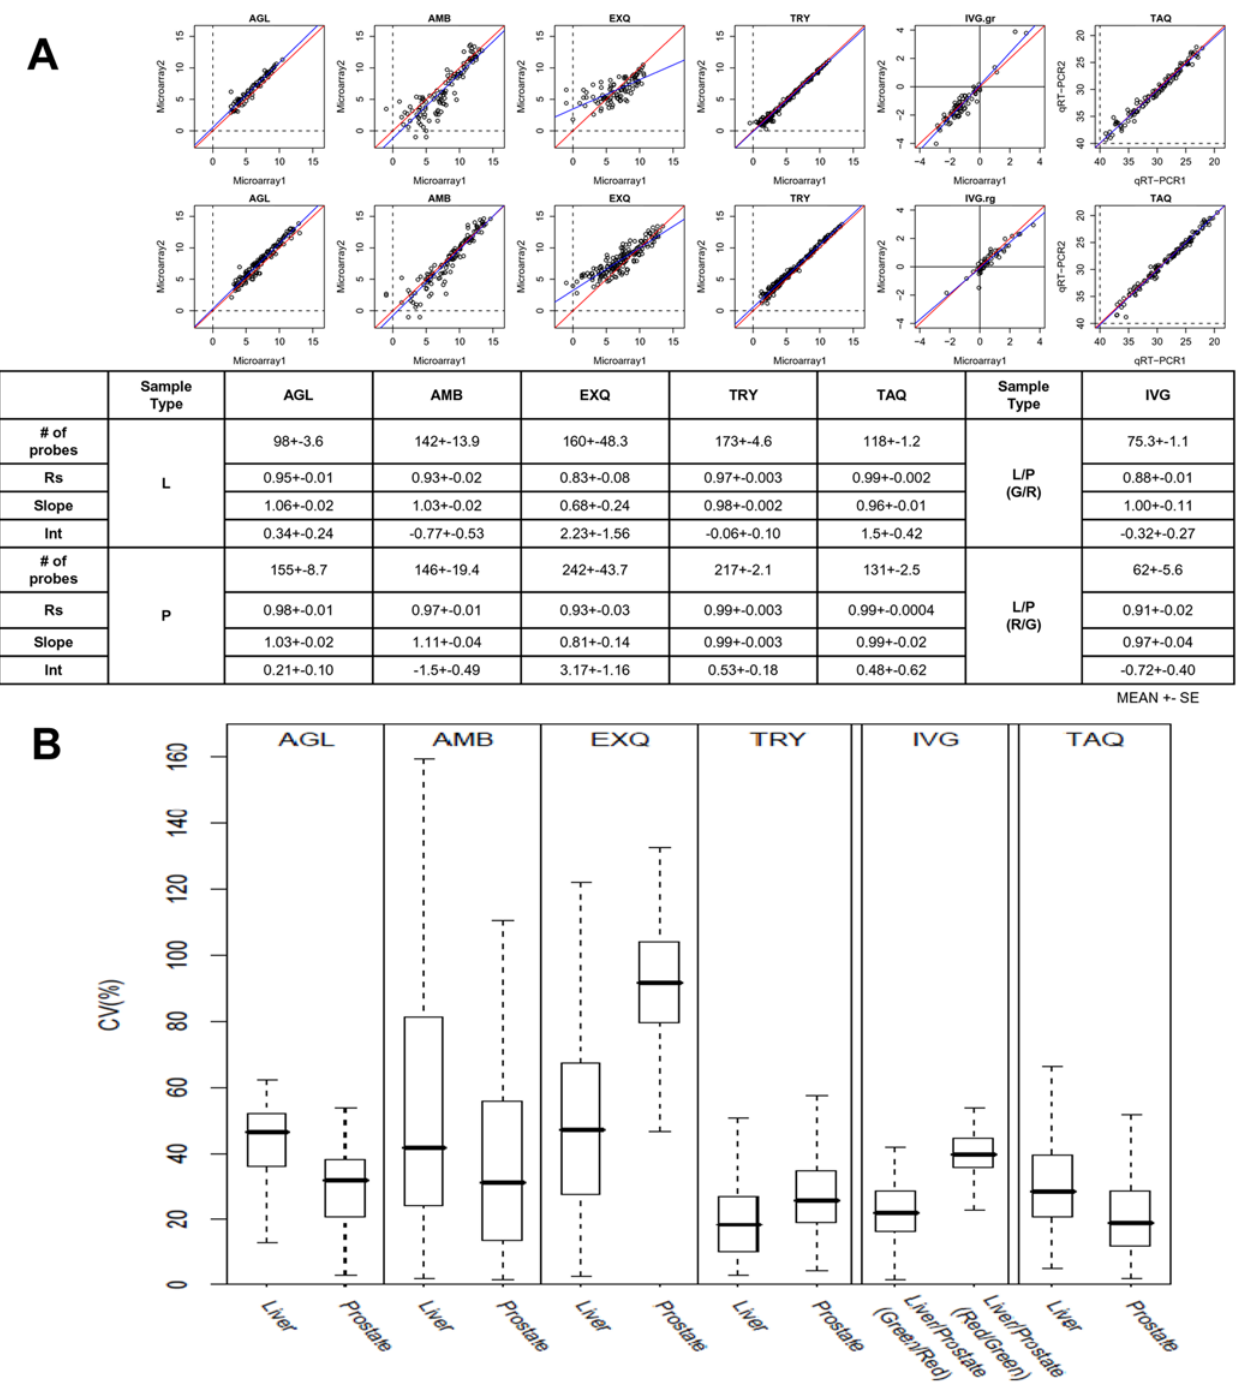
Figure 2. Intra-platform repeatability of quantitative assessment of microRNA expression. MicroRNA measurement of the same sample (L: human liver, P: human prostate) was replicated three times. Only data of microRNAs with positive detection call were used for analysis. 2A : Scatter plots show the correlation between replicate 1 and 2 (scatter plots for all possible combinations between three replicates were shown in Figure S4). Spearman’s correlation coefficients (Rs) for replicates 1 vs. 2, 1 vs. 3, and 2 vs. 3 were calculated and summarized in lower table. Rs for the prostate sample were generally better than those for the liver sample (p=0.0005, paired T-test). This finding suggests that repeatability of microRNA would depend on the sample cell type, and that repeatability in the case of samples expressing A higher amount of microRNAs would be better. TAQ (Taqman analysis) obtained the best Rs values despite a slightly wider spread of data. It might be a result from wider range of microRNA detection (microarray: 2 16 , Taqman: about 2 20 ). 2B : Box plot of coefficient of variation (CV) for microRNA detection platforms. The coefficient of variation for each microRNA assessment was calculated by a formula, CV=(standard deviation/mean) 6 100, and the distribution of CV was plotted in the box plot diagram. Bold line: median, bottom and top line of the box: first and third quantile, respectively.